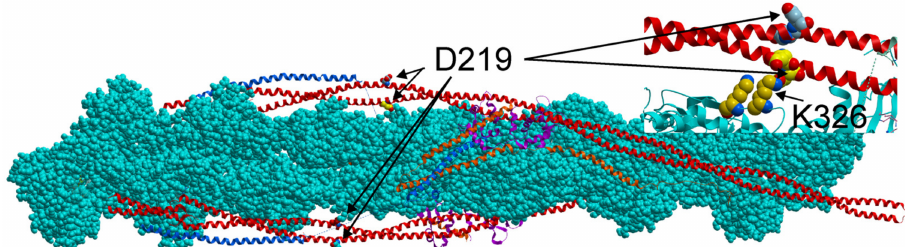
Figure 7. Location of the D219 Tpm residues in the structure of the regulatory unit of the thin filament of cardiac muscle ([31]; PDB code 6KN7). Actin atoms are shown by space-filling (CPK) representation (cyan); the Tpm molecules are shown by red ribbons; Tn-Cs are magenta ribbons; Tn-Is are orange ribbons; and Tn-Ts are blue ribbons. An h -bond between the D219 residue of Tpm and the K326 residue of actin is shown in the inset. Neighbor E218 residue of Tpm and the K328 residue of actin are also shown in CPK.